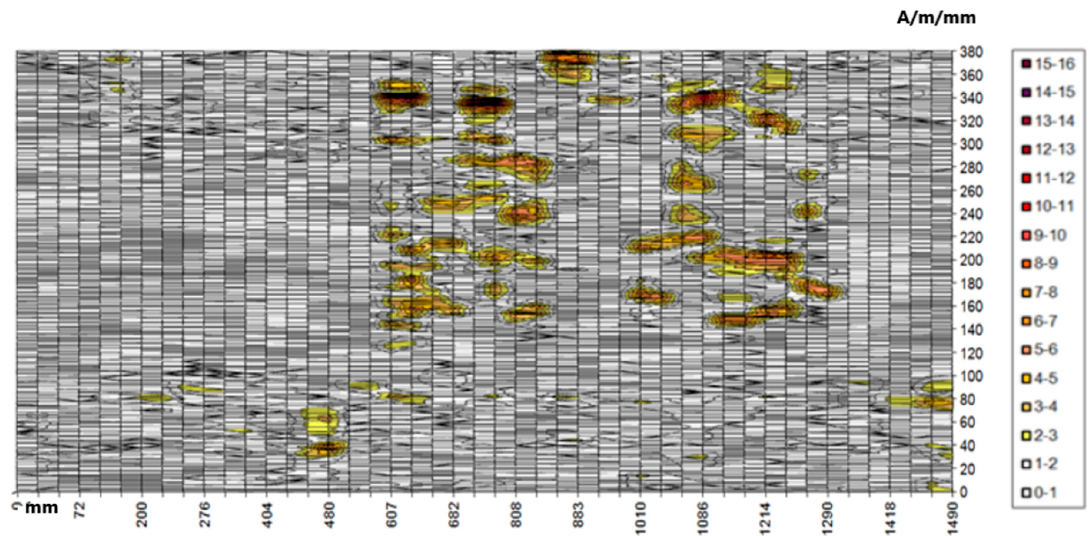
Figure 7. Distribution of tangential component Hpy for the selected area.